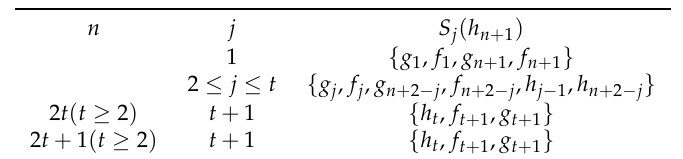
Table 2. S j ( h n + 1 ) for N e